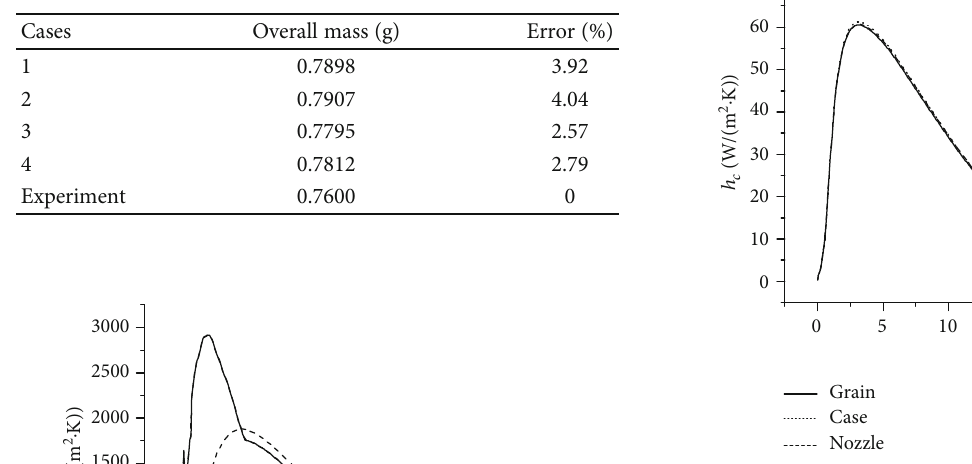
Figure 9: Radiative heat transfer coe ffi cient results.